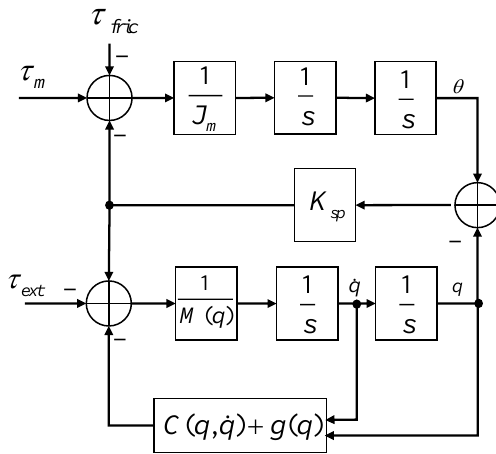
where M ( q ) denotes the inertia matrix, C ( q , ˙ q ) denotes the centripetal and Coriolis matrix and g ( q ) denotes the gravity vector. θ and q are, respectively, the motor and link angles. τ ext and τ sp are the external torque applied to the robot link and the torque applied by the elastic-joint deformation, respectively. τ m and τ fric denotes motor torque acting on the motor inertia J m and friction torque. K sp denotes the Hooke coefficient of the torsion spring in the joint of the series elastic actuator.